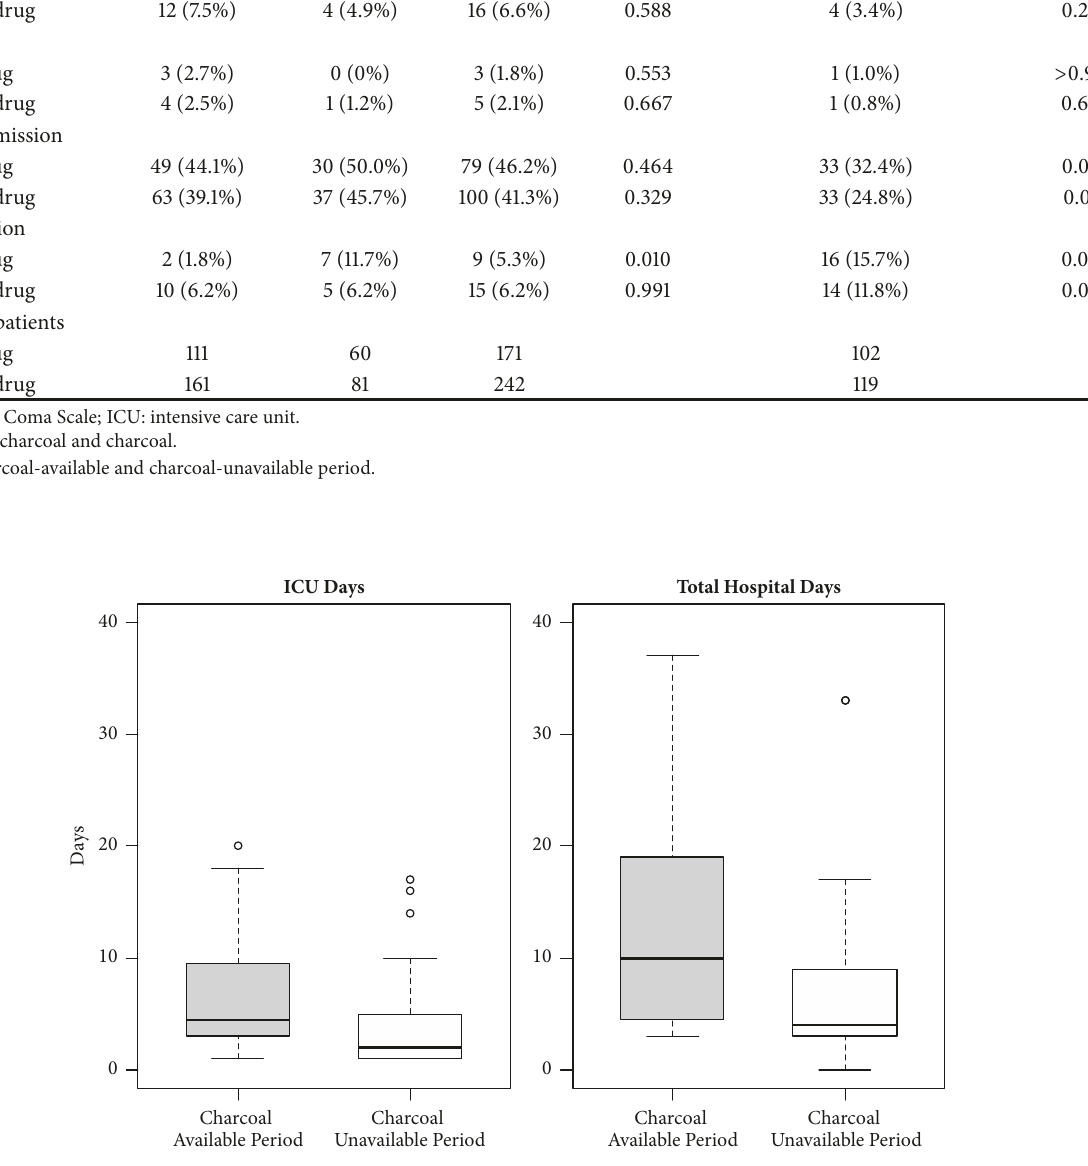
Figure 1: Length of stay of patients admitted to ICU between charcoal-available and charcoal-unavailable periods. ∗ ∗ One extreme outlier case is present in charcoal-unavailable period (41 ICU days and 91 total hospital